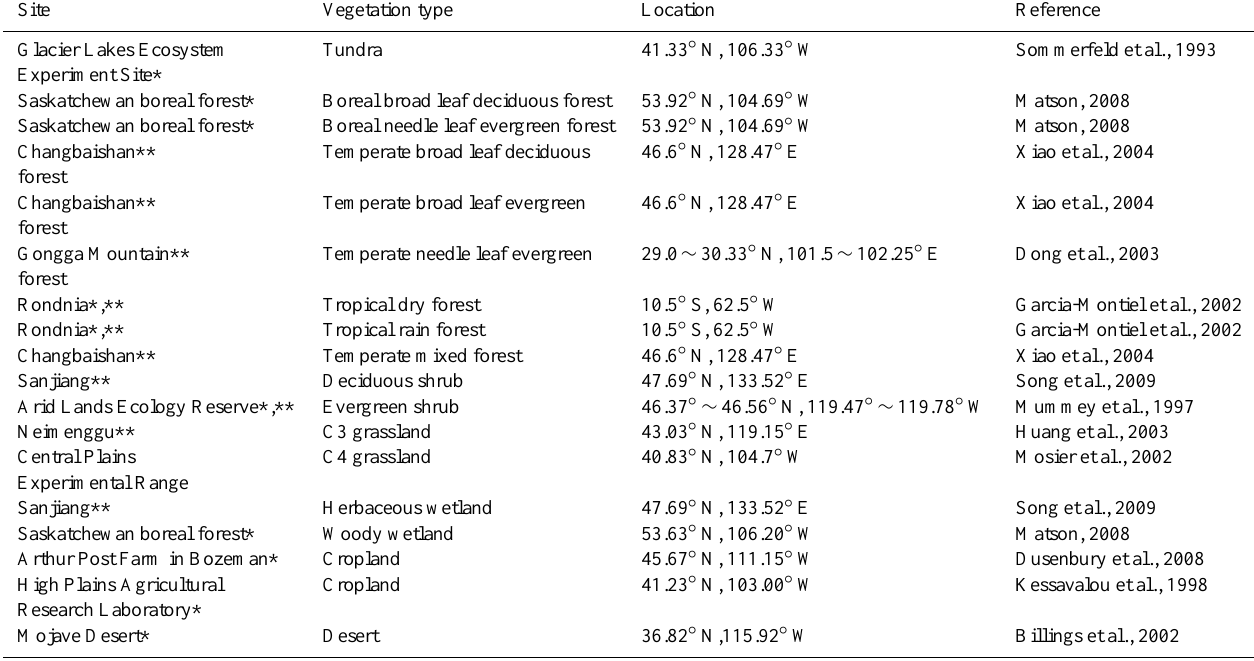
Table 3. Study sites from which N 2 O and auxiliary data were collected and used in the calibration of the Dynamics Land Ecosystem Model (DLEM).